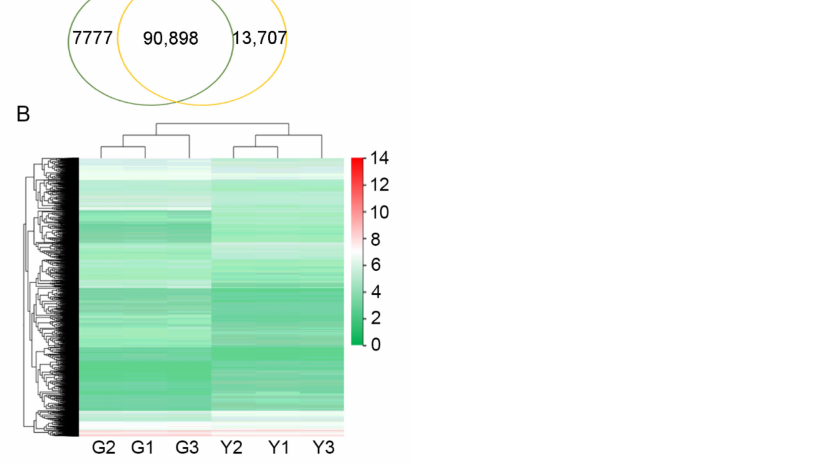
Figure 3. Unigene expression in green and yellow tissues. ( A ) Venn diagrams showing genes expressed in green and yellow tissues. G: the shared genes among the three biological replicates for green tissues; Y: the shared genes among the three biological replicates for yellow tissues; ( B ) heat map showing the expression pattern of genes in green and yellow tissues. Expression level of genes was computed as log10-transformed values of fragments per kilobase per million reads